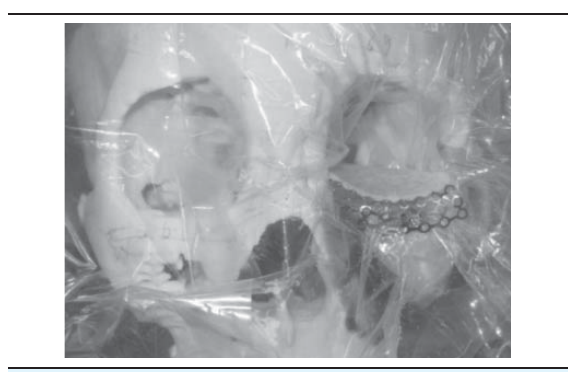
Figure 3. Preadaptation of titanium mesh embedded in Synpor® The D Titanium mesh embedded is preformed with the rapid protoyped - 3D dimensional model. The patient underwent open reduction and orbital fl